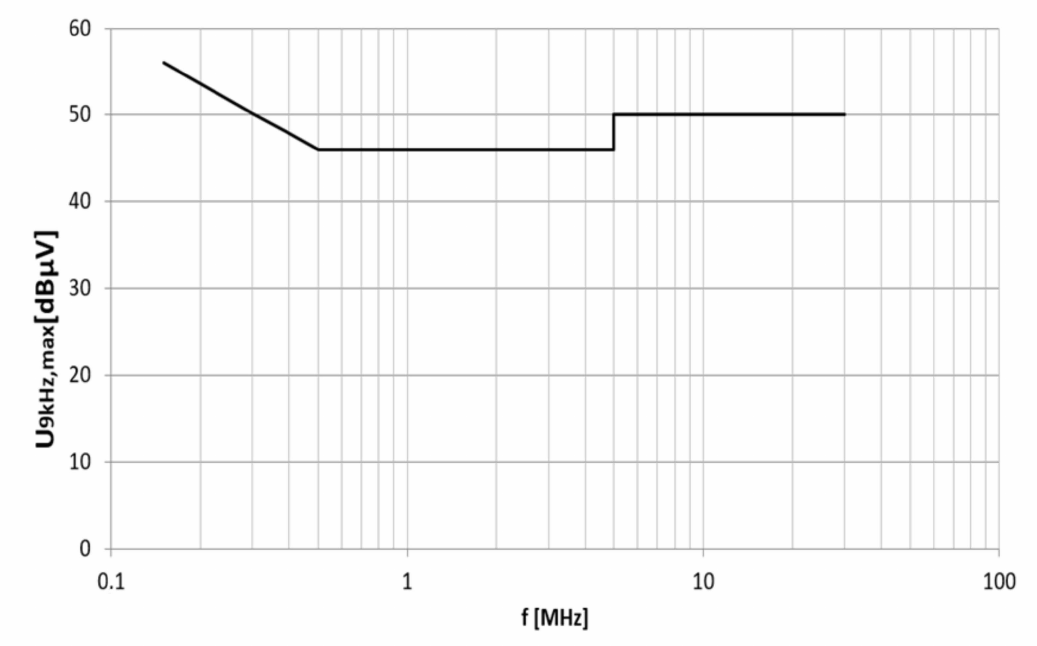
Figure 3. Limits for the average level of conducted disturbance emissions at power supply terminals for Class B IT equipment in the frequency range from 0.15 MHz to 30 MHz